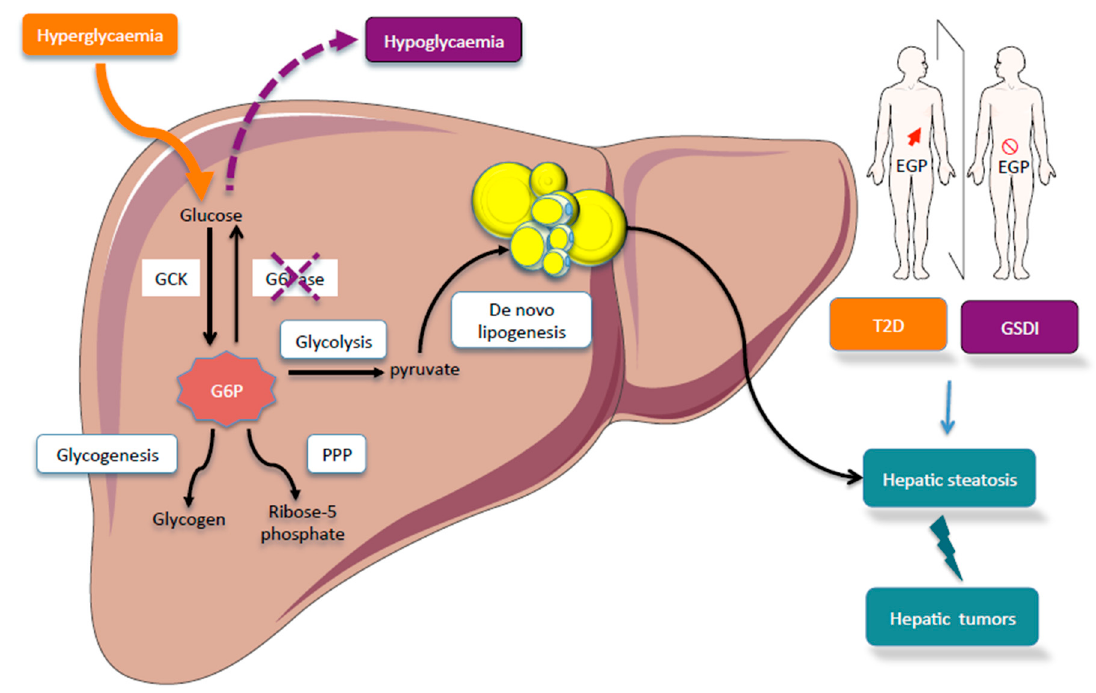
Figure 2. Comparison of hepatic glucose metabolism in glycogen storage disease type I (GSDI) or type 2 diabetes. Type 2 diabetes is characterized by an increase in endogenous glucose production (EGP) while GSDI is due to an absence of EGP. In GSDI, the absence of G6Pase activity is responsible for G6P accumulation in the hepatocyte. In diabetes, hyperglycemia is responsible for the increase flux through G6P. In both cases, this leads to a metabolic reprogramming characterized by the activation of glycolysis, PPP, and de novo lipogenesis. This metabolic reprogramming promotes hepatic steatosis in type 2 diabetes and GSDI, in which the risk of liver tumorigenesis is increased. Figures were drawn using Sevier Medical Art images.